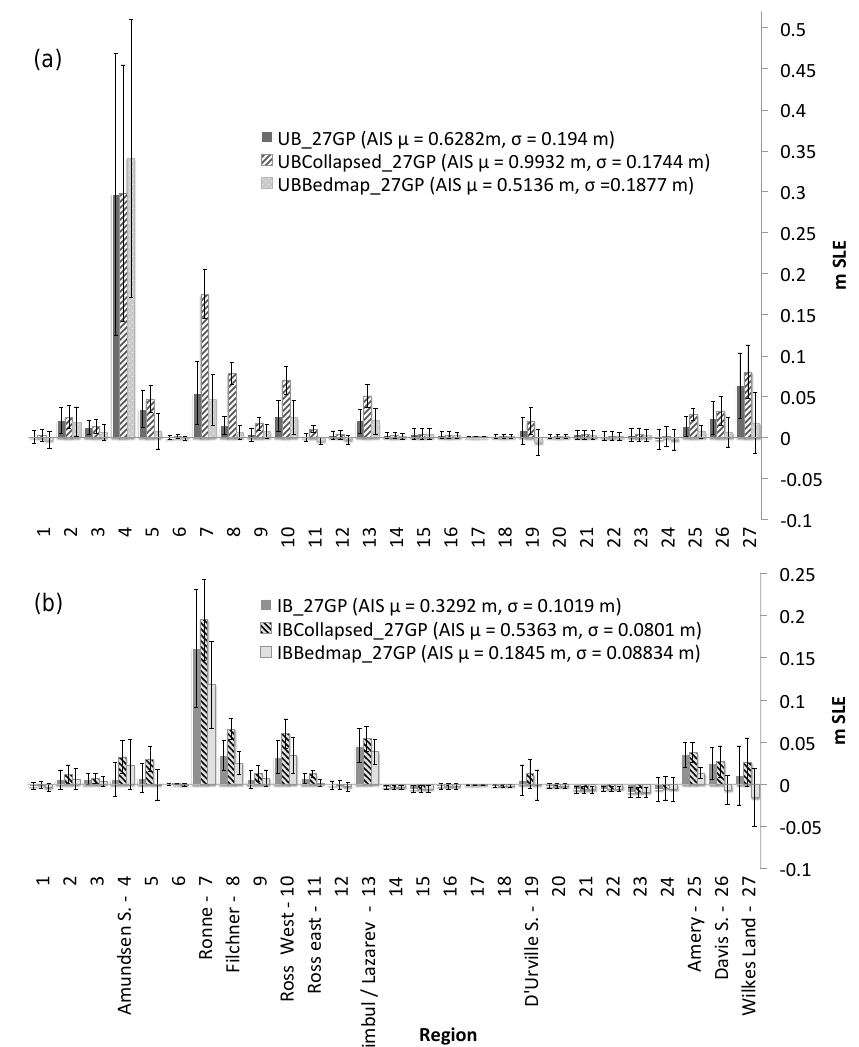
Figure 6. Same as Fig. 4 but comparing the combined variable GP experiments, the combined variable GP experiments with ice shelves collapsed, and the combined variable GP Bedmap1 experiments ( a , UB; b ,